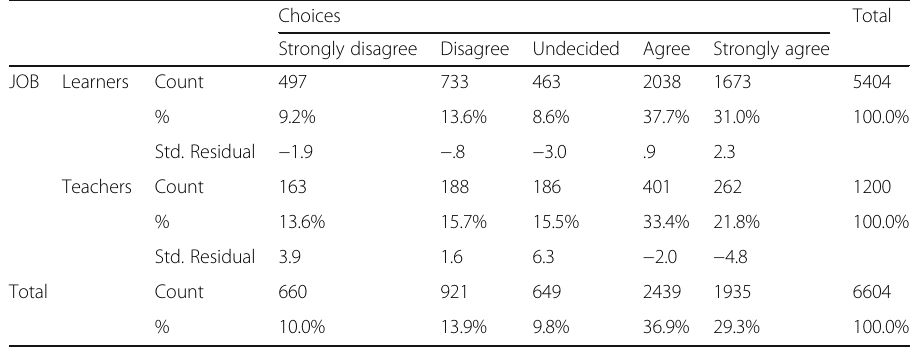
Table 6 Frequencies, percentages and standardized residuals of the teachers-learners ’ perceptions towards explicit grammar instruction and corrective feedback Choices Total Strongly disagree Disagree Undecided Agree Strongly agree JOB Learners Count